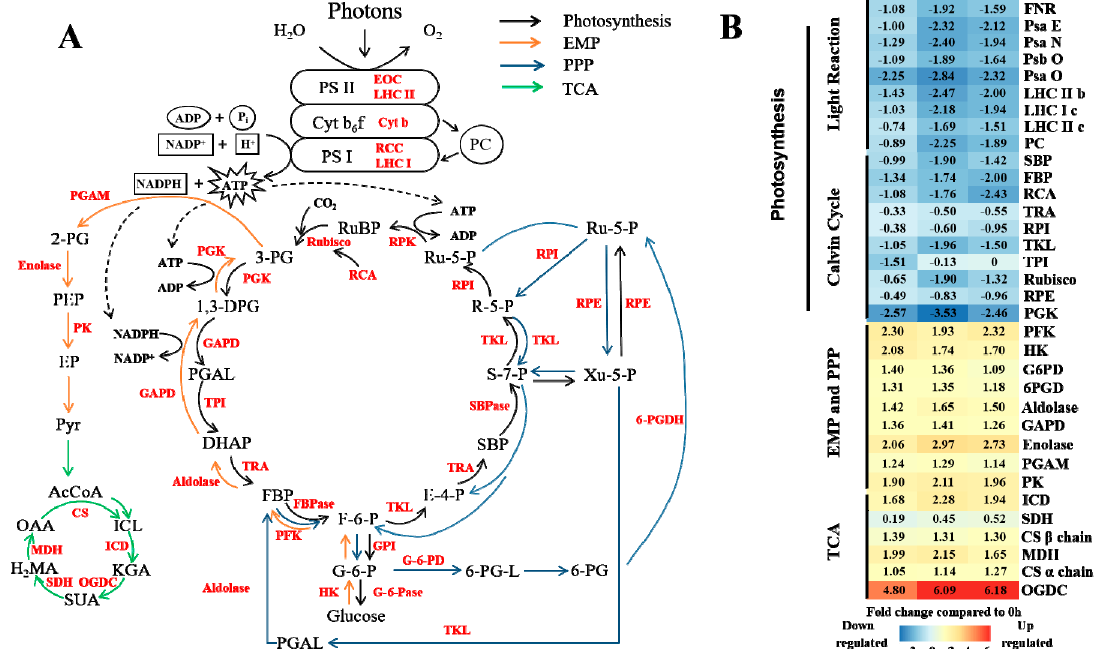
Figure 2. Influence of high CO 2 concentration on energy metabolism. ( A ) The main energy pathways in plants. Black, orange, blue and green arrows represent photosynthesis, the Embden-Meyerhof-Parnas (EMP) pathway, the pentose phosphate (PPP) pathway and the tricarboxylic acid (TCA) cycle, respectively. The di ff erent enzymes are shown in red font. ( B ) Expression changes in the genes involved in metabolic pathways in response to stress. White indicates no change, red up-regulation, and blue down-regulation in each treatment, as shown in the color bar for a log 2 fold change scale. The abbreviations in the figure are shown in Table A2 from Appendix